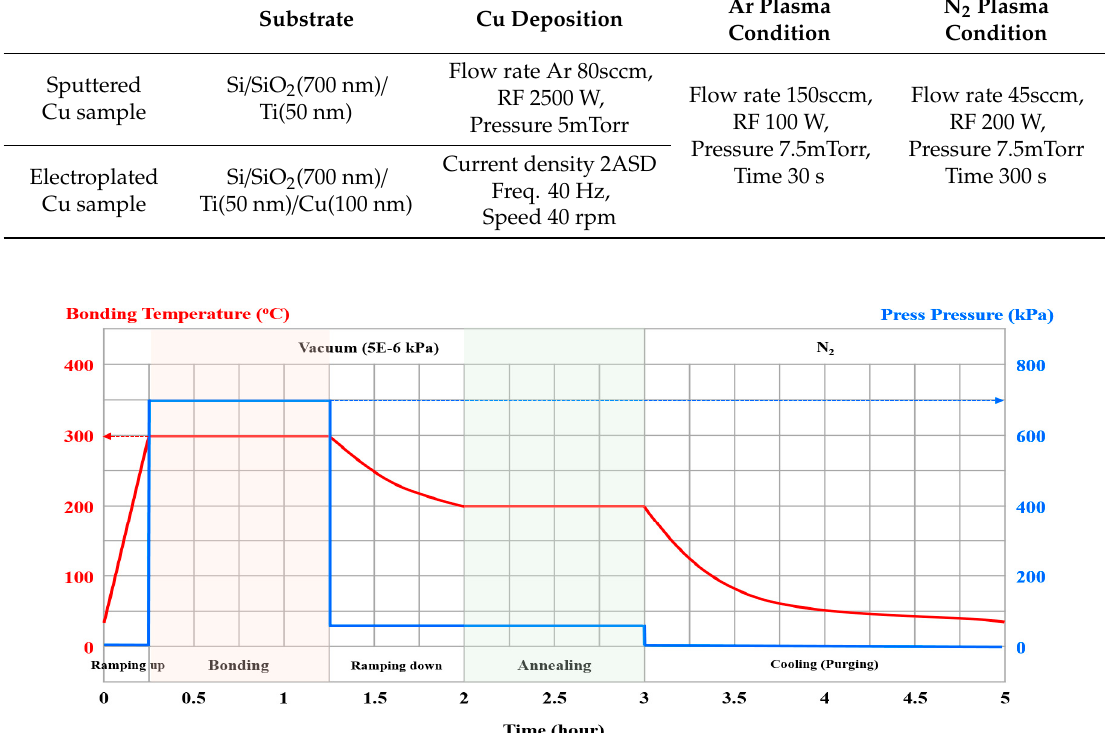
Figure 2. Bonding process profile.